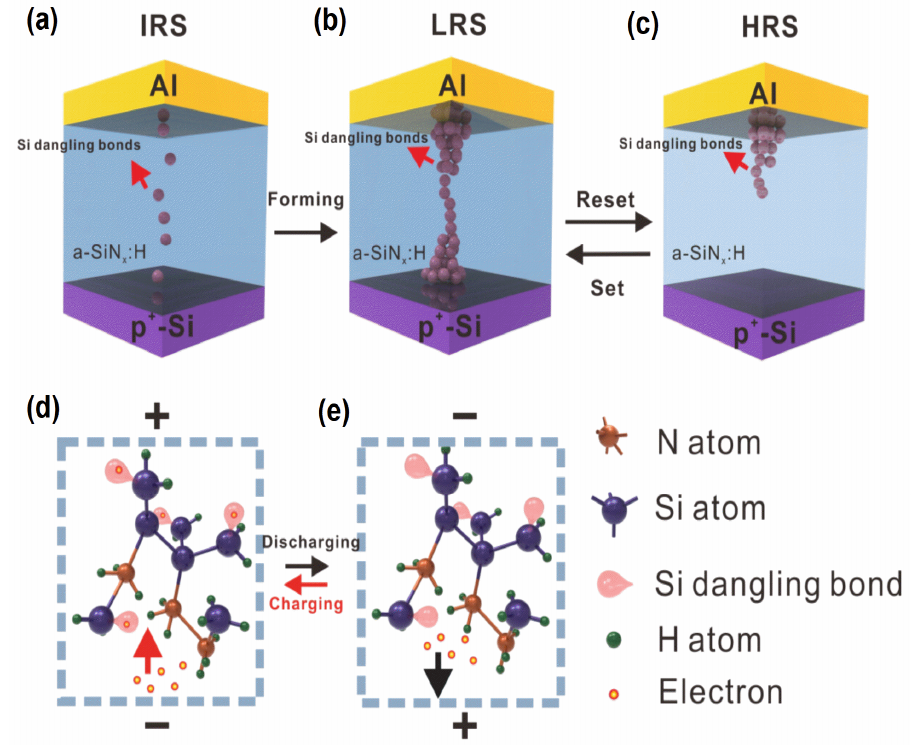
Figure 4. ( a–c ) The Si dangling bond distribution of the a-SiN 1.17 :H device in the IRS, LRS, and HRS. ( d–e ) Schematic illustration of electrons trapped and released by Si dangling bond during the charging and the discharging process.